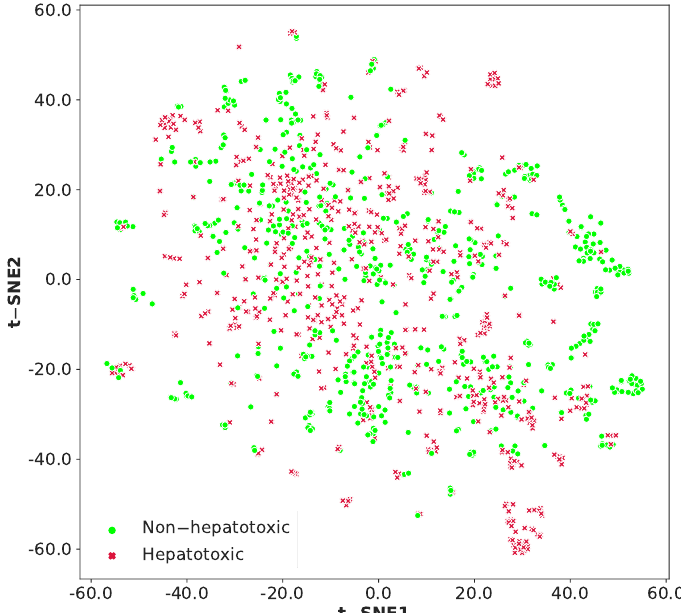
Figure 5. Visualizing the chemical space coverage using t-distributed stochastic neighbor embedding (t-SNE) on PCA output with 100 principal components (accounts for 56.76% of the overall variance) of the entire dataset (training and test datasets). Red x markers represent the hepatotoxic compounds and the green circle markers represent the non-hepatotoxic compounds.